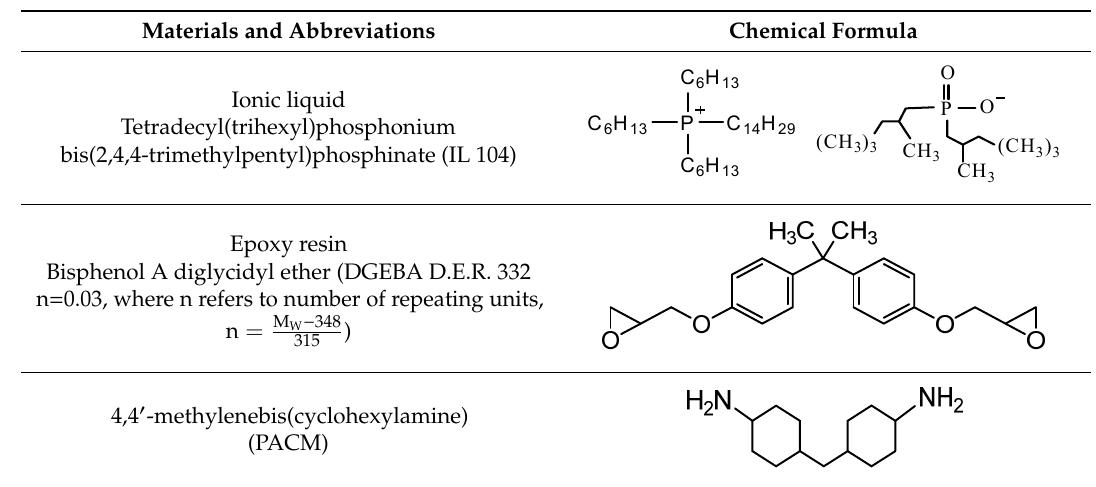
Table 1. Materials and their chemical structures.